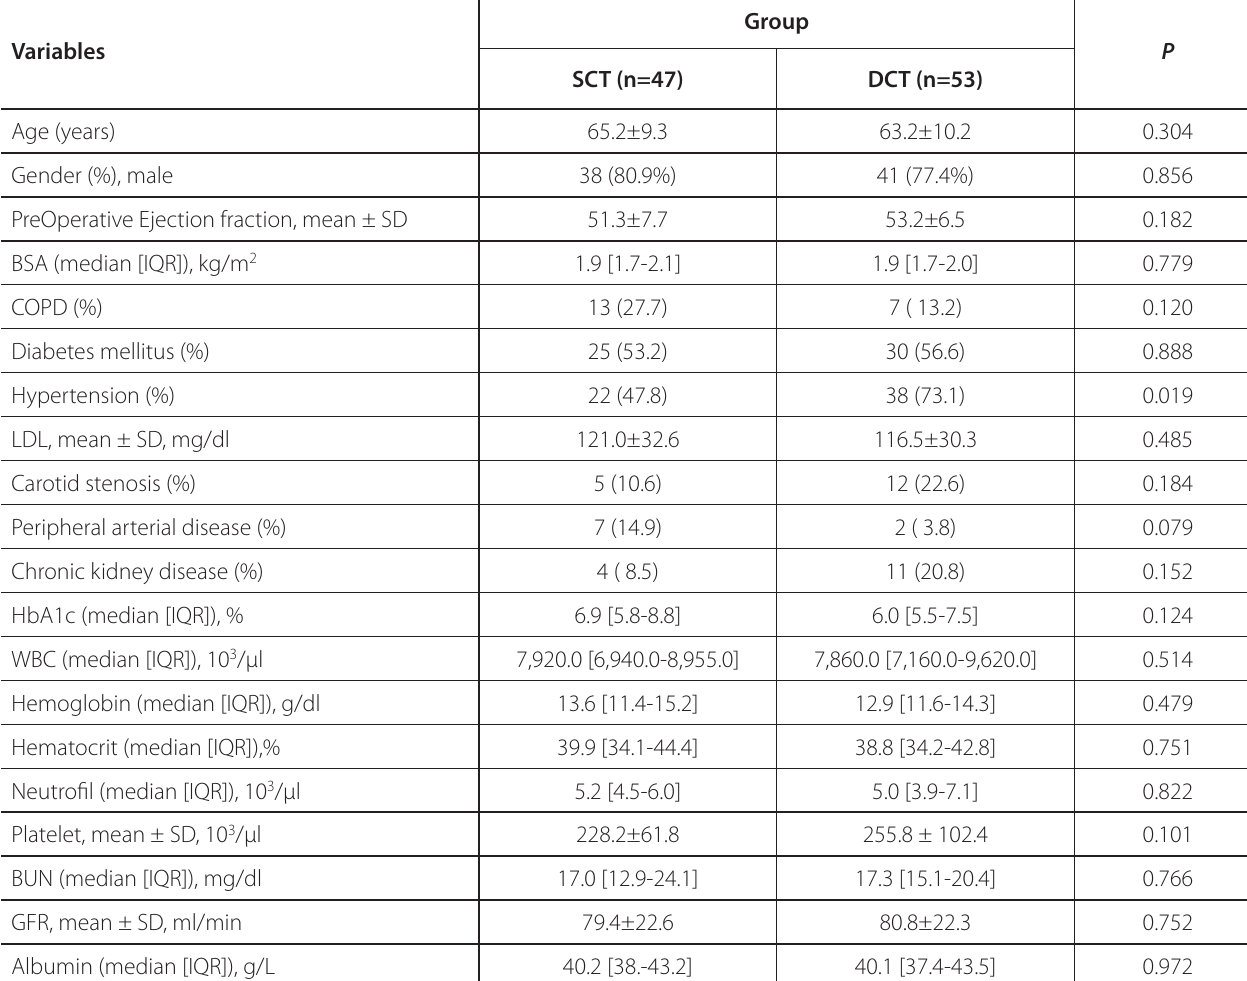
Table 1 . Preoperative demographic, laboratory and comorbidity features of SCT and DCT groups.